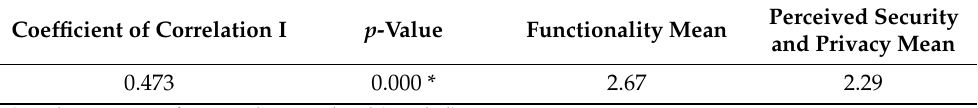
Table 7. Correlation between functionality and perceived security and